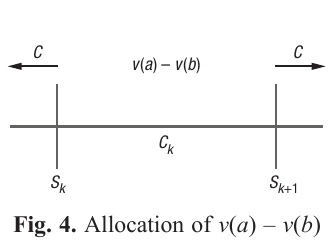
Fig. 4. Allocation of v ( a ) – v ( b ) to a category C